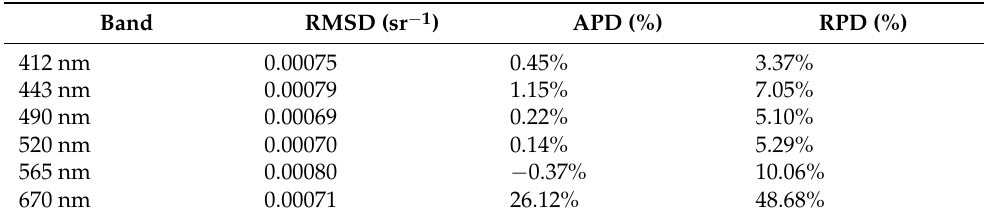
Table 1. The statistical parameters obtained by the algorithm are verified using precision evaluation datasets for different